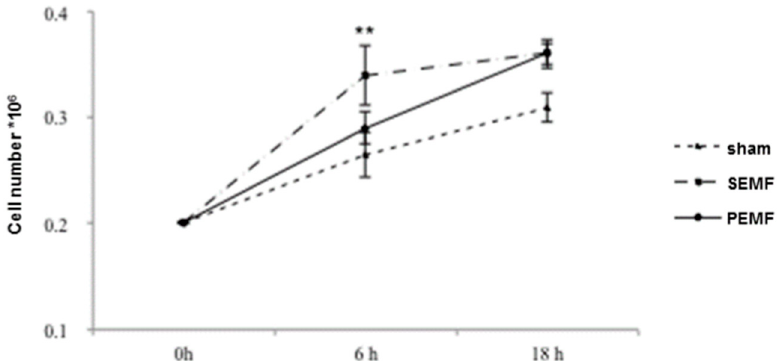
Figure 1. Numbers of human gingival fibroblast (hGF) cells following exposure to two types of electromagnetic field (EMF). The hGF cell numbers were calculated after 6 and 18 h exposure to a sham, a sinusoidal electromagnetic field (SEMF), and a pulsed electromagnetic field (PEMF). The means ± standard deviation (SD) of the change from baseline (0 h) over time are reported in the graph. Experiments were carried out in duplicate, and hGFs derived from the 11 recruited patients, were analyzed. ** p -Value < 0.01 SEMF vs.